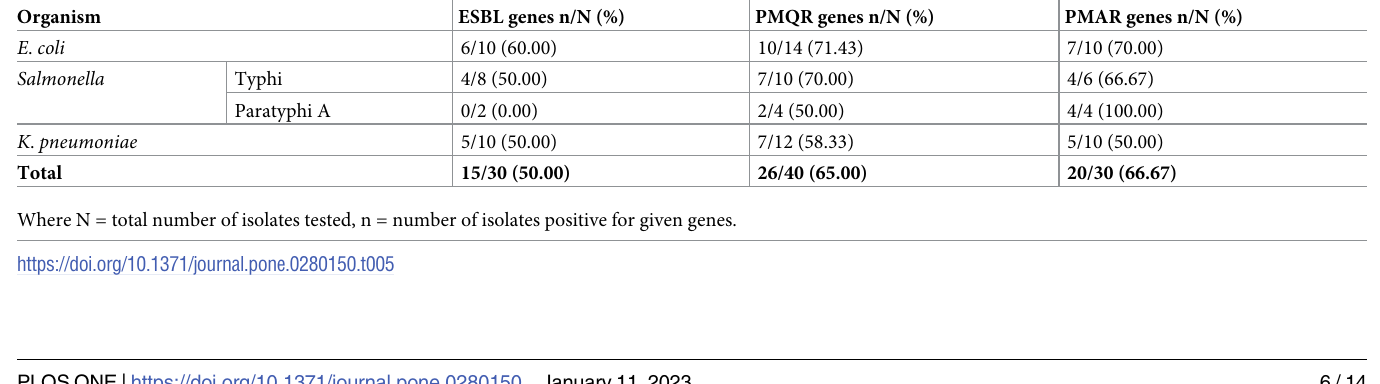
Table 5. Prevalence of resistance genes in susceptible isolates. Organism